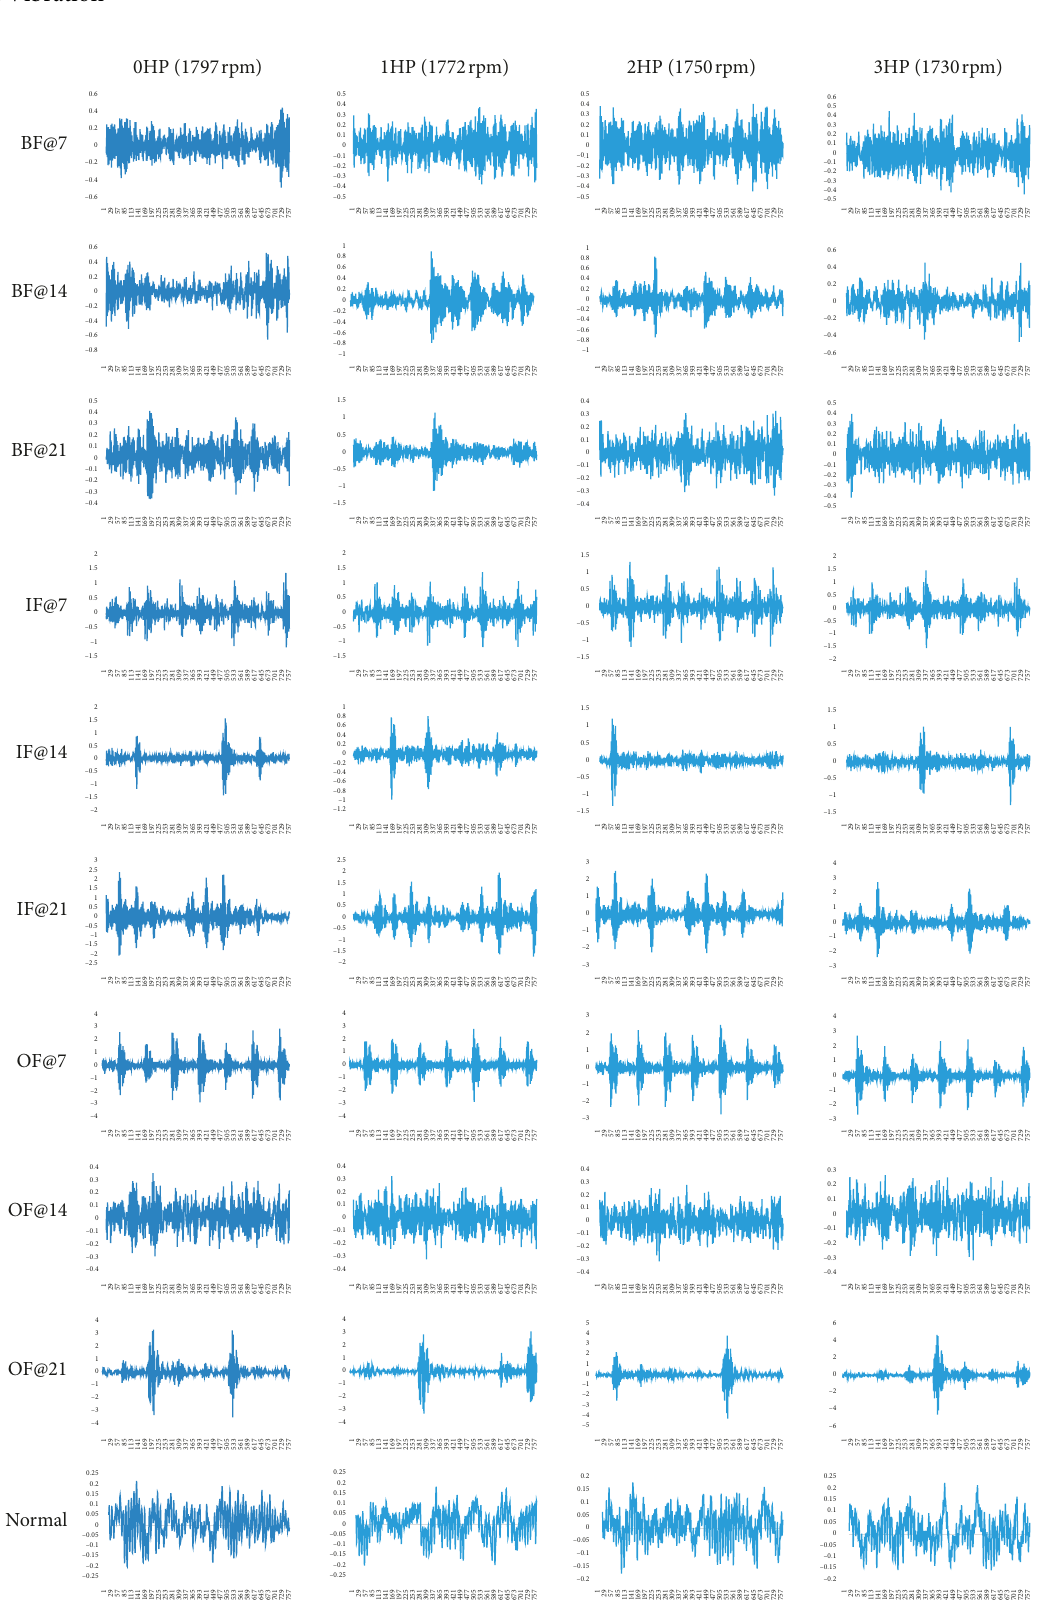
Figure 5: Original waveform of various working